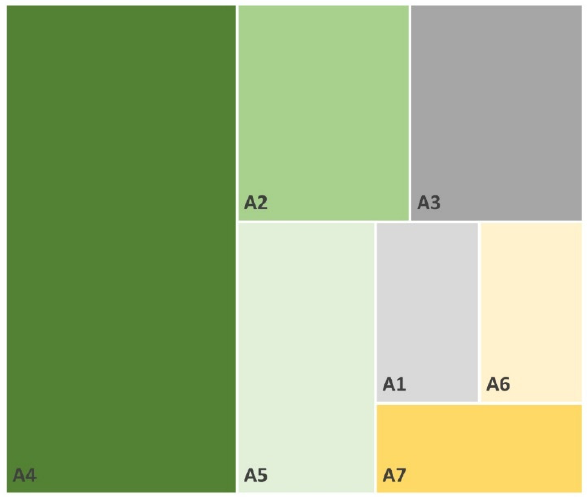
Figure 6. Distribution of number of papers on current challenges and trends for CM of WTs.